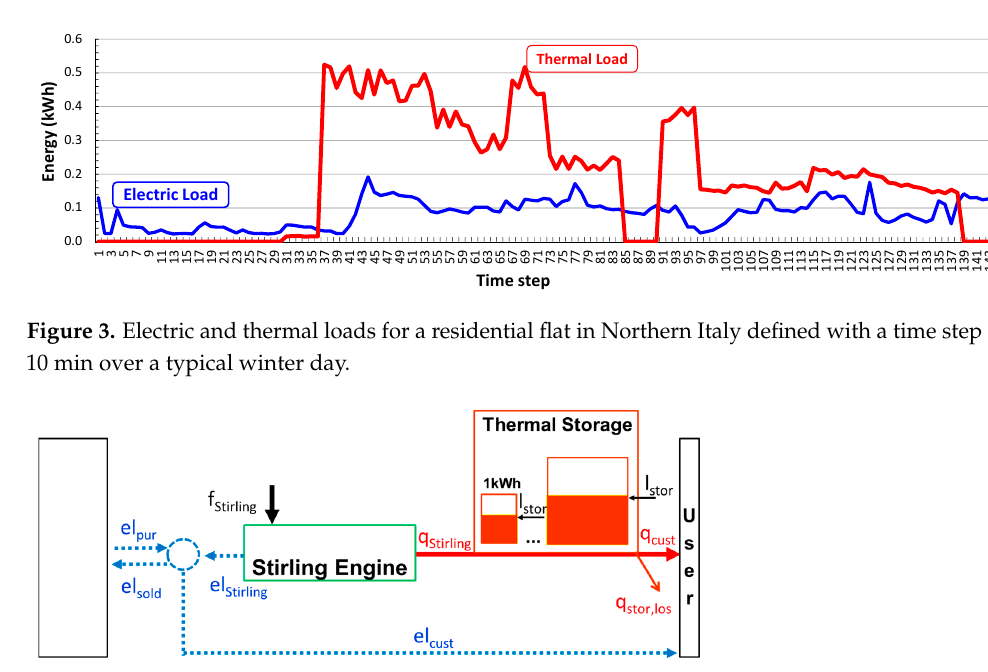
Table 3. Energy and cost assumptions adopted in the simulations.